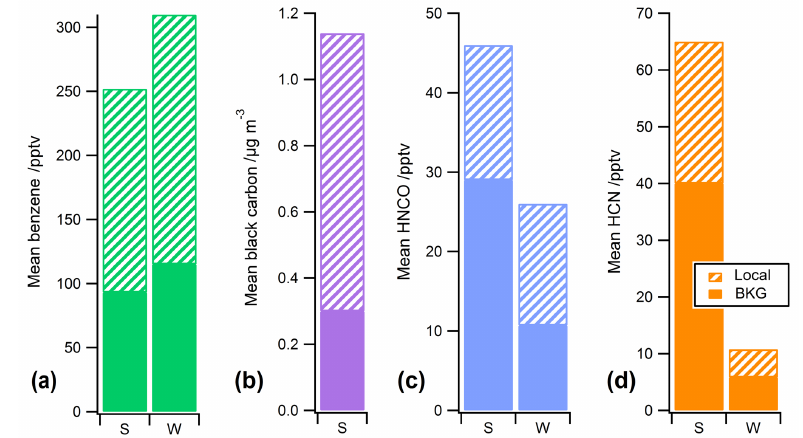
Figure 2. Mean on-road (LOCAL, patterned) and background (BKG, solid) mixing ratios for the summer (S) and winter (W) campaigns.